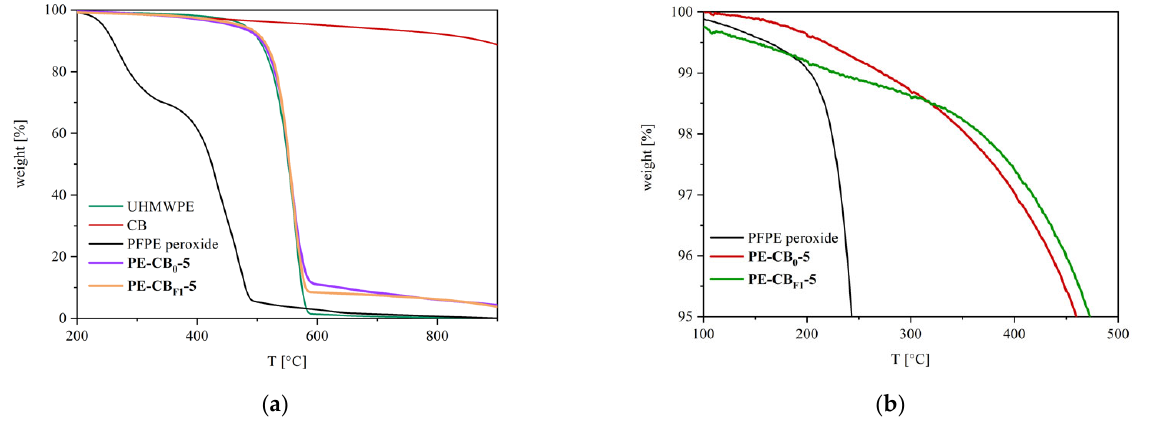
Figure 9. Thermogravimetric profiles of pristine UHMWPE, bare CNTs, PFPE peroxide, PE ‐ CNT 0 ‐ 3 and PE ‐ CNT 0 ‐ 5 ( a ), PE ‐ CNT F1 ‐ 3, PE ‐ CNT F2 ‐ 3, PE ‐ CNT F1 ‐ 5 and PE ‐ CNT F2 ‐ 5 ( b ) and a detail of the thermograms between 0 to 5 wt.% weight loss of PFPE peroxide, PE ‐ CNT 0 ‐ 5, PE ‐ CNT F1 ‐ 5 and PE ‐ CNT F2 ‐ 5 ( c ).